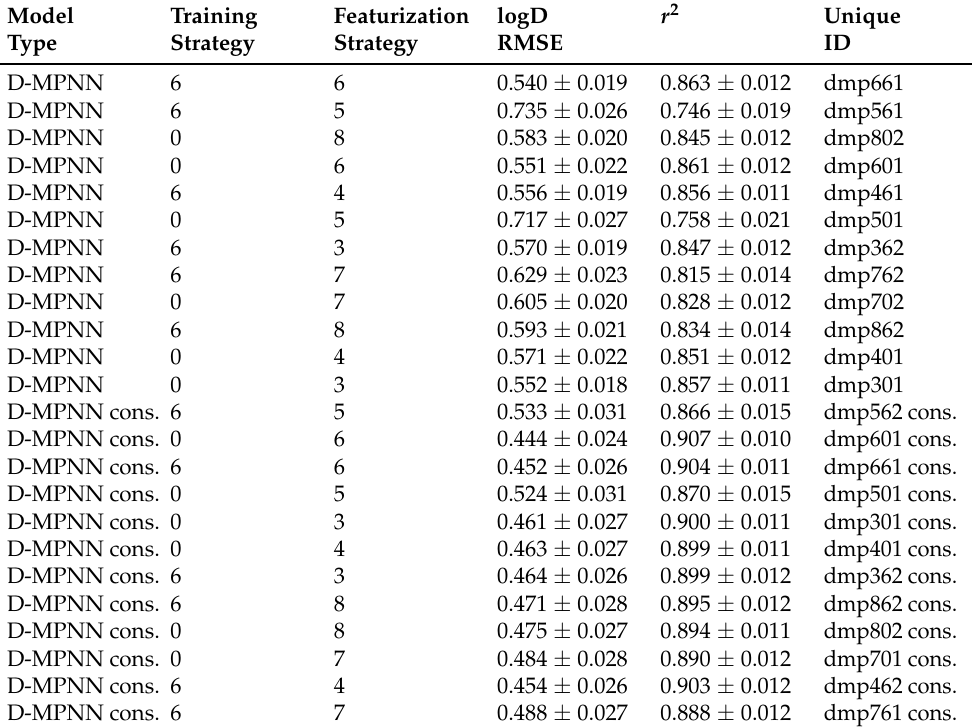
Table A17. Shows the logP RMSE and r 2 results for the D-MPNN model type used during this survey. The last column consists of the unique identifier. Training strategy 0 represents a training strategy combining logD, logS, and logP, 1 represents a strategy combining logD and logP, 2 stands for a combination of logD and logS, 3 represents a strategy using logS and logP, 4 represents a strategy using logD, 5 represents a strategy using logS, and 6 represents a strategy using logP.